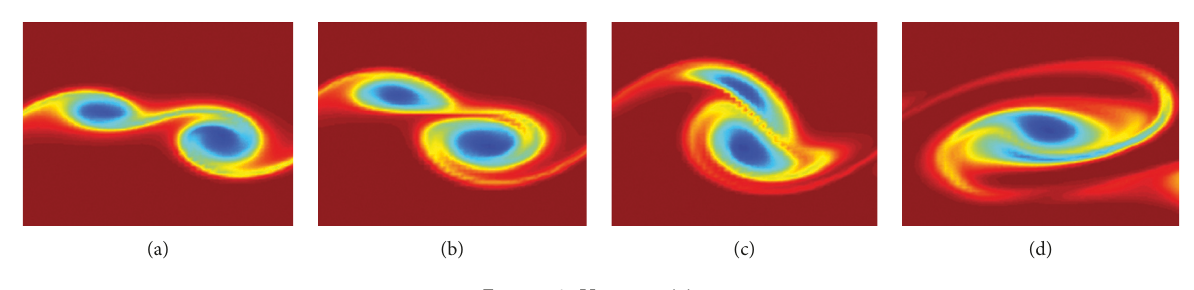
Figure 3: Vortex pairing.